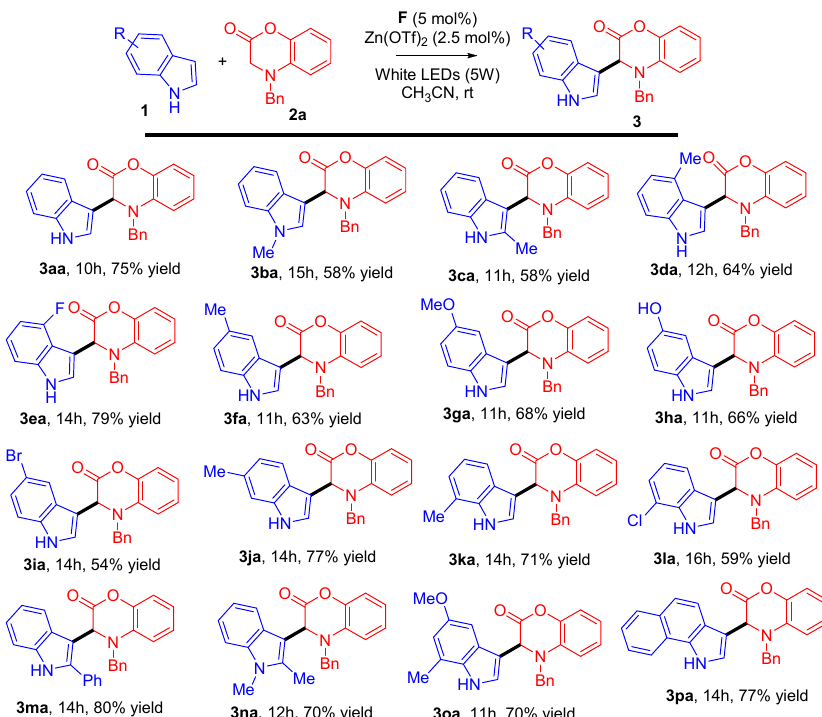
Scheme 1. Scope of the Friedel-Crafts reaction with different indoles 1 and 2a . Reaction conditions: 1